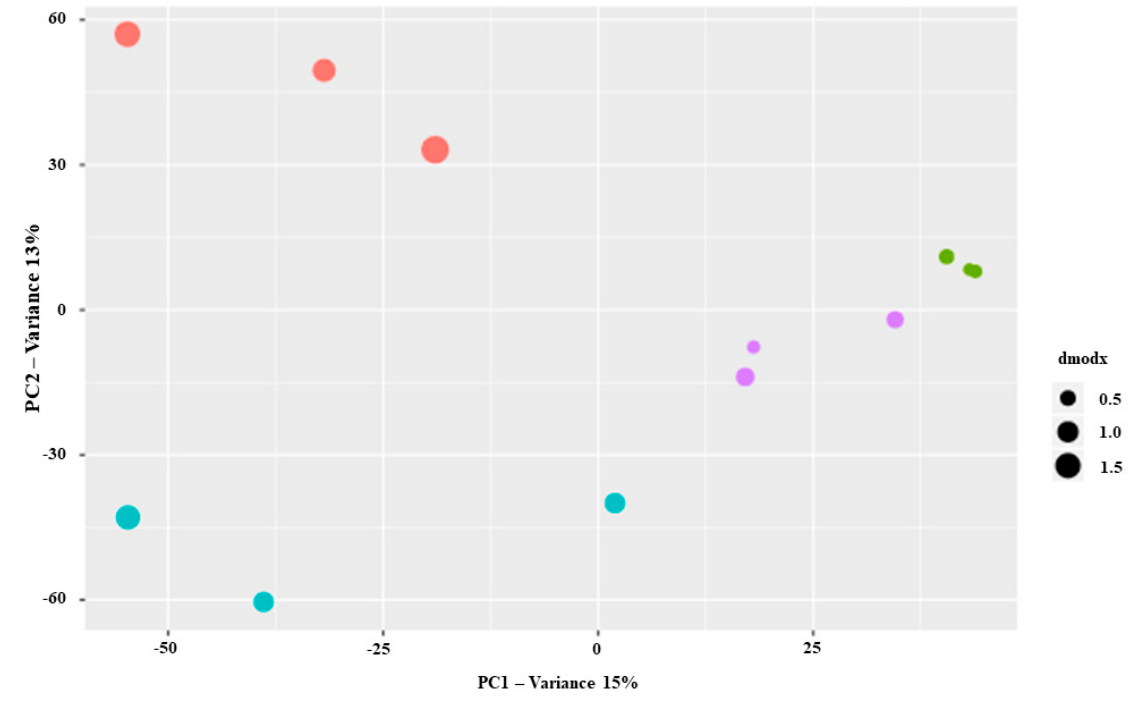
Figure 2. Principal component analysis of untargeted metabolomics data from different leaves (sessile and petiolate) and sites [Mosorrofa (Mo) and Puzzi (Pu)] of Salvia ceratophylloides individuals: Mo-sessile (red), Mo-petiolate (green), Pu-sessile (blue) and Pu-petiolate (purple). Table 5 . Chemical characterization of volatile organic compounds in fresh sessile and petiolate leaves of two sites [Mo- sorrofa (Mo) and Puzzi (Pu)] of Salvia ceratophylloides plants.